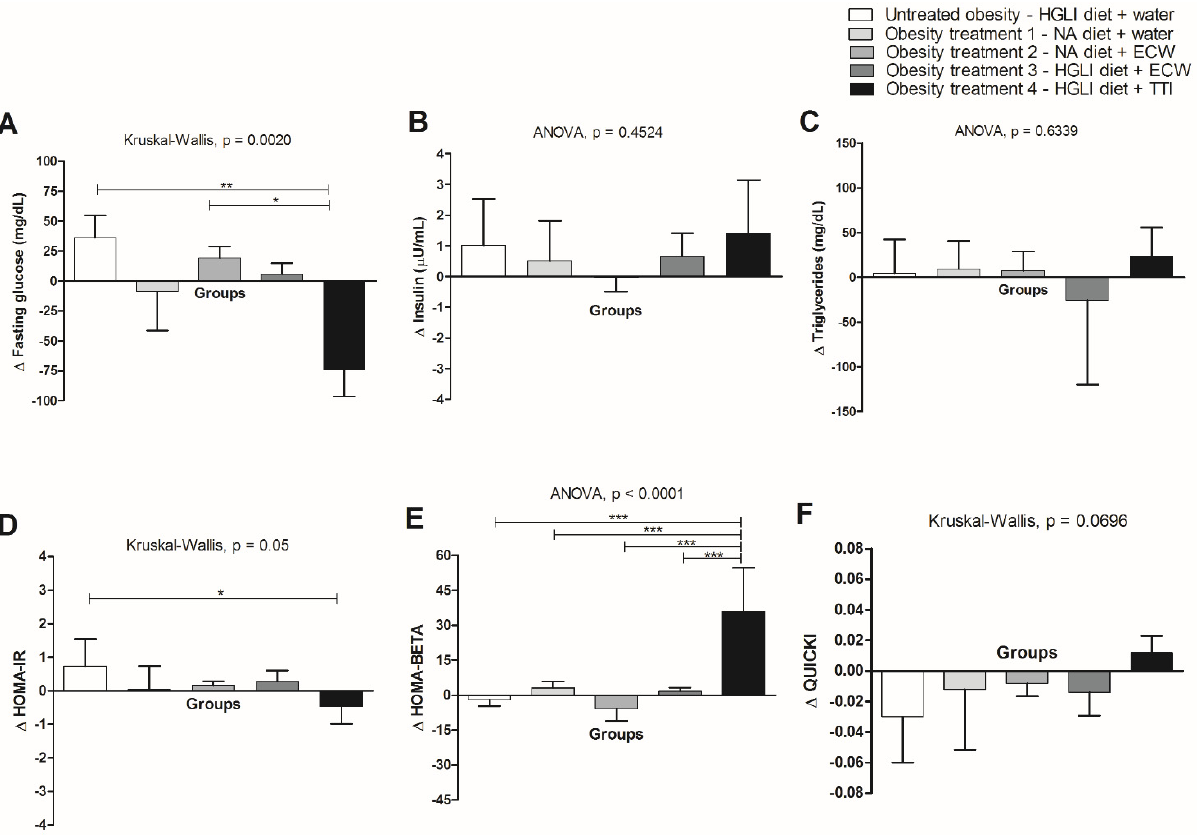
Figure 4. Biochemical parameters in obese Wistar rats submitted for ten days to different types of treatment: ( A ). Fasting glucose. ( B ). Insulin. ( C ). Triglycerides. ( D ). HOMA-IR. ( E ). HOMA-BETA. ( F